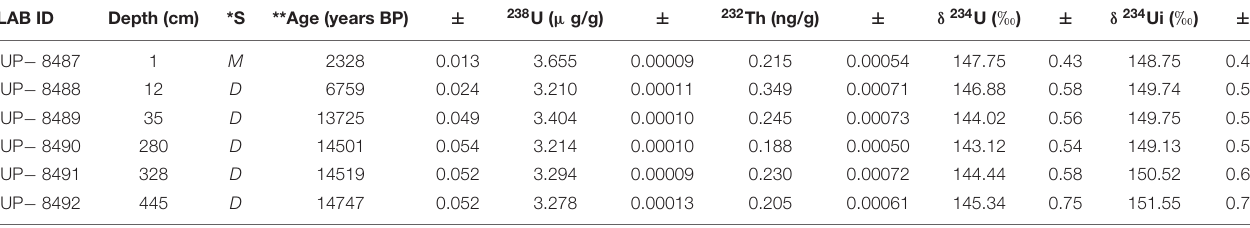
TABLE 1 | Uranium-series isotope (U/Th) ages of cold-water coral fragments. LAB ID